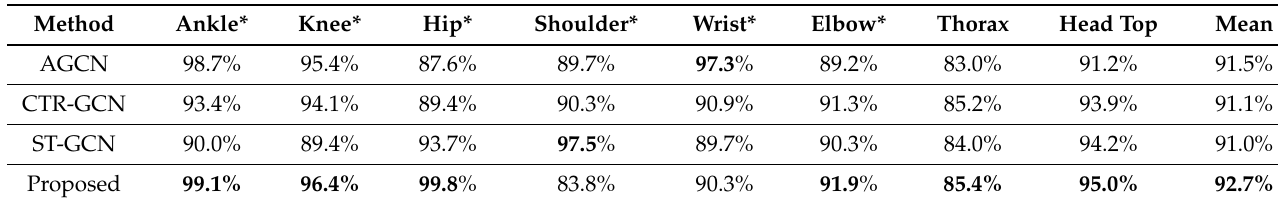
Table 5. PCK of different methods on the MPII dataset.